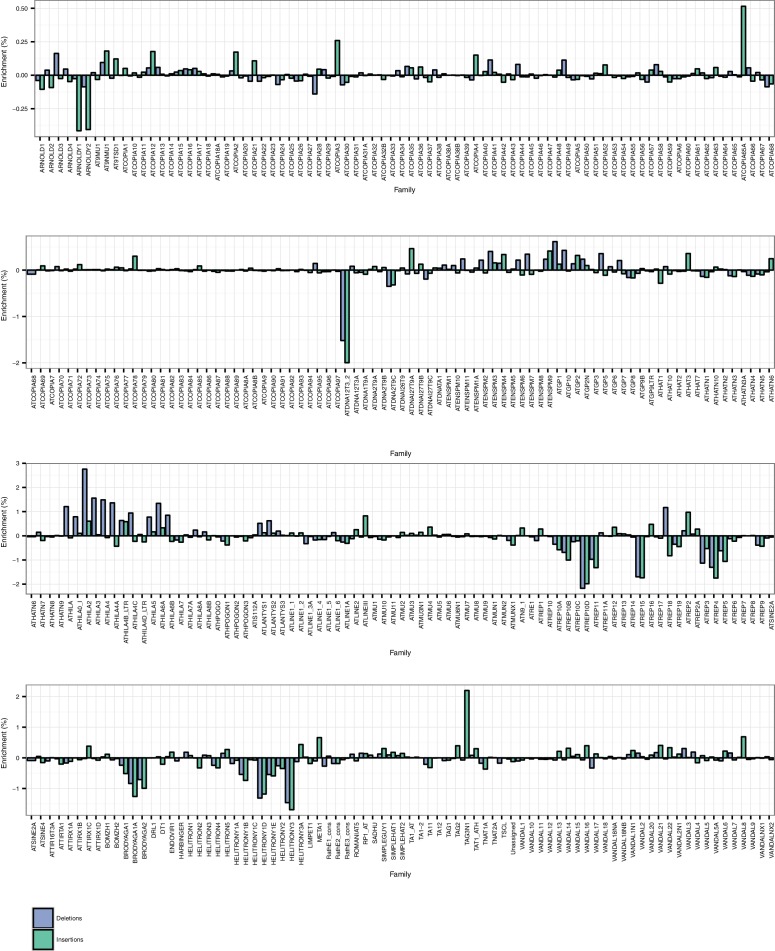
TE family enrichments and depletions for TE insertions and TE deletions.